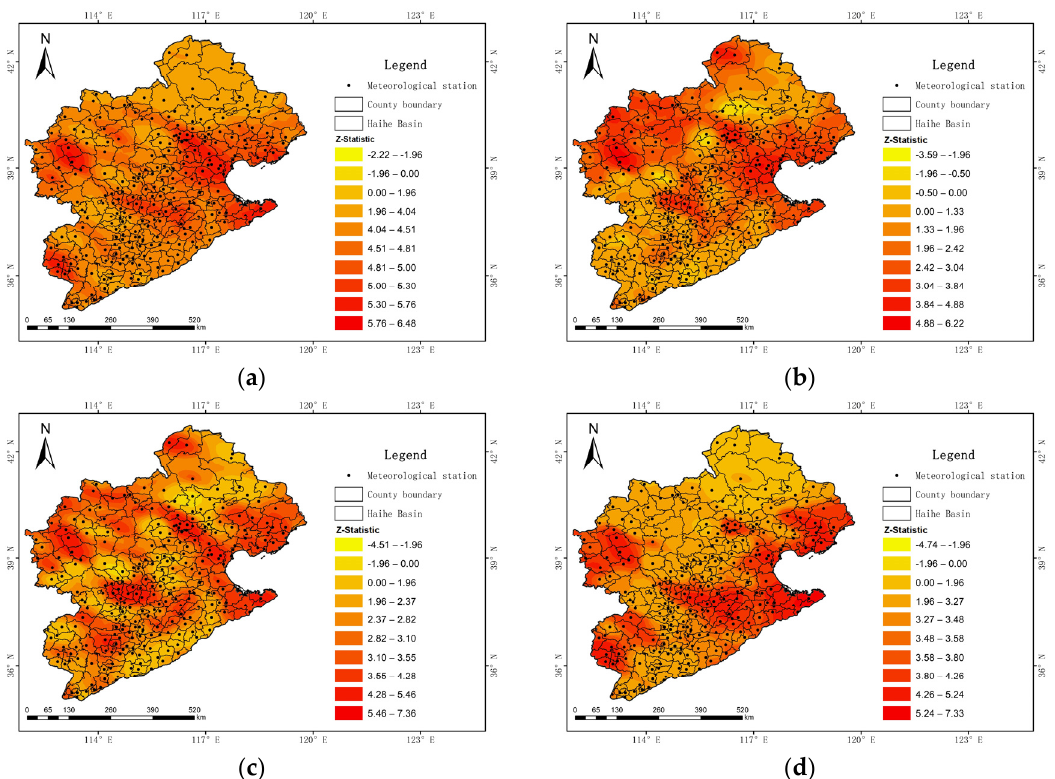
Figure 4. Spatial distribution of the significance of mean temperatures for different seasons. ( a ) Spring; ( b ) summer; ( c ) autumn; ( d ) winter.